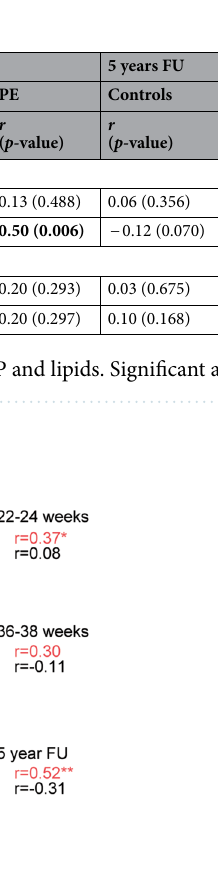
Figure 2. Expression of TERC and XRN1 in extracellular vesicles and associations with expression in PBMC ( A ) Expression of TERC and XRN1 in extracellular vesicles during pregnancy and 5 years follow-up in controls and PE. ( B ) Correlation plot (Pearson) between the expression of TERC and XRN1 in extracellular vesicles and in PBMC at the different timepoints within the PE and control groups. * p < 0.05, ** p <